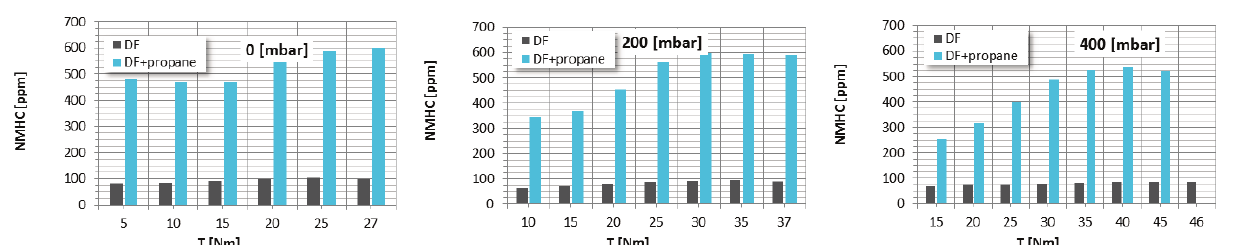
Fig. 6. Load characteristics of nitrogen oxides (NOx) concentration in the exhaust gas for both investigated engine operating modes